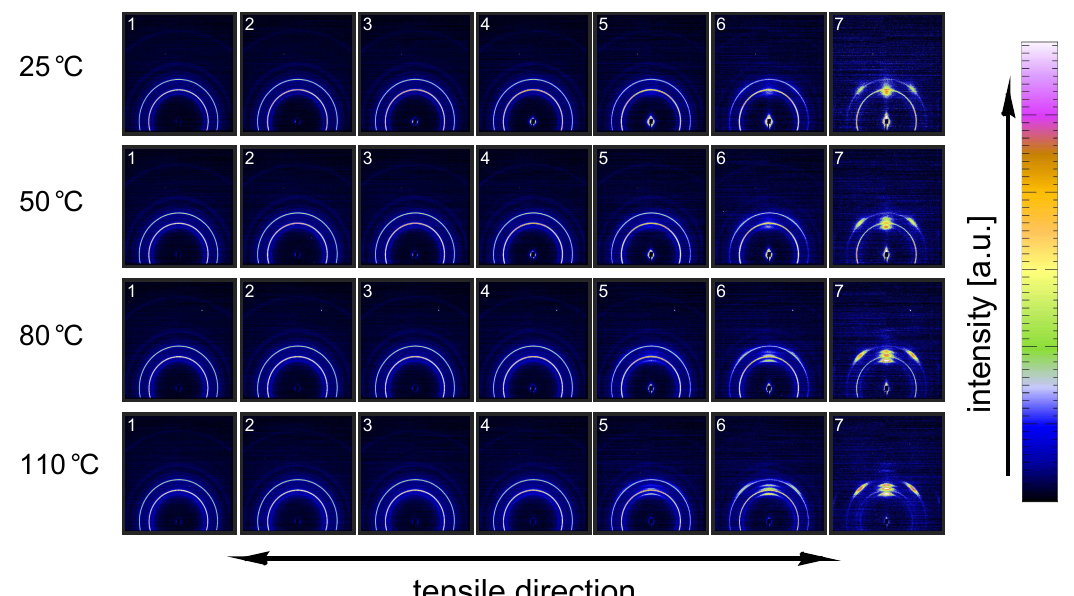
Figure 13. Normalized 2D-patterns of β -iPP stretched at temperatures of 25, 50, 80 and 110 ◦ C from top to bottom. The true strains, determined with the assumption of fully uni-axial deformation, are given as well. The macroscopic strains at which the patterns were taken are indicated by the markers in Figure 8. The stretching direction is